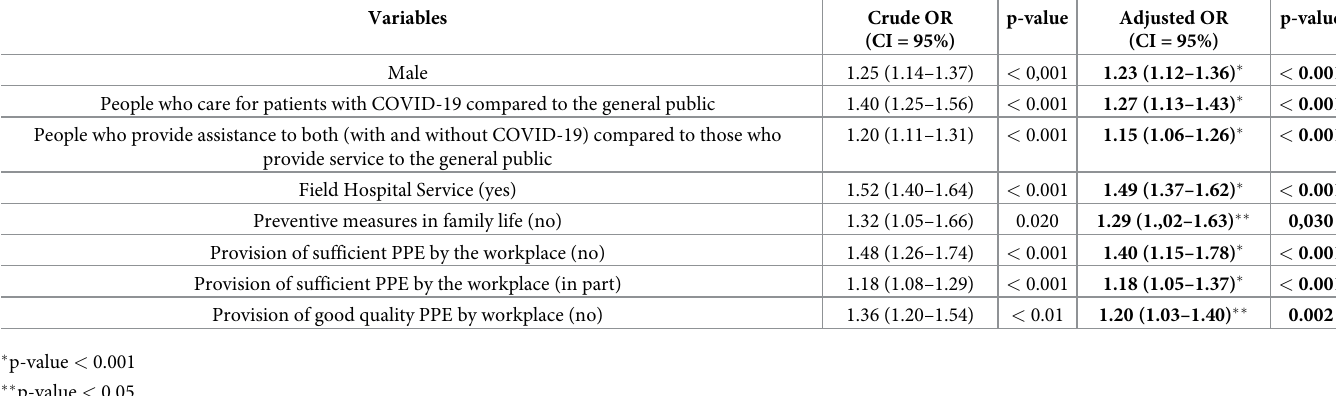
Table 3. Odds ratios by logistic regression for the diagnosis of COVID-19 among health professionals, Brazil, 2020.